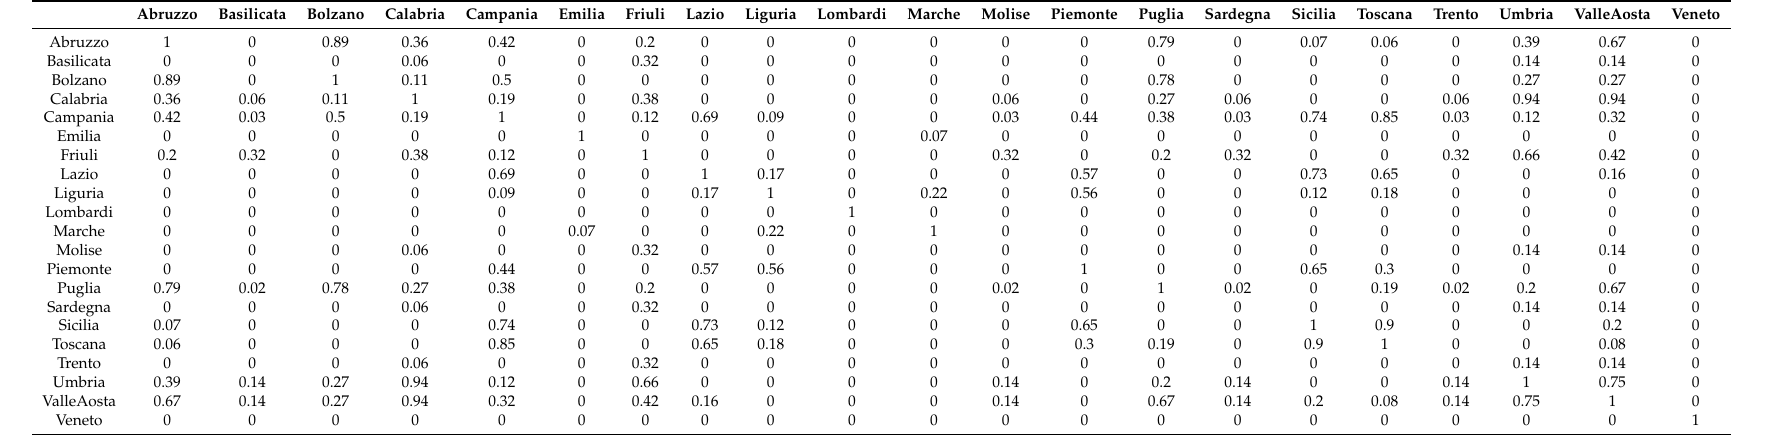
Table A50. Similarity values of Total Cases network in the first